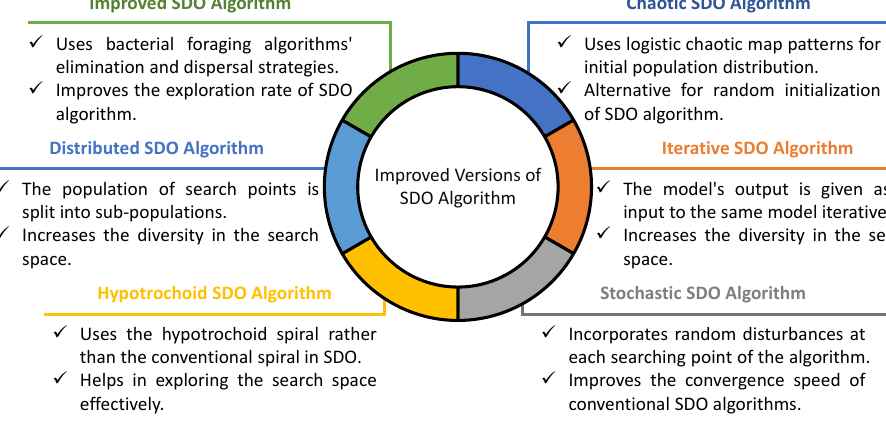
Figure 6. Improved versions of the SDO